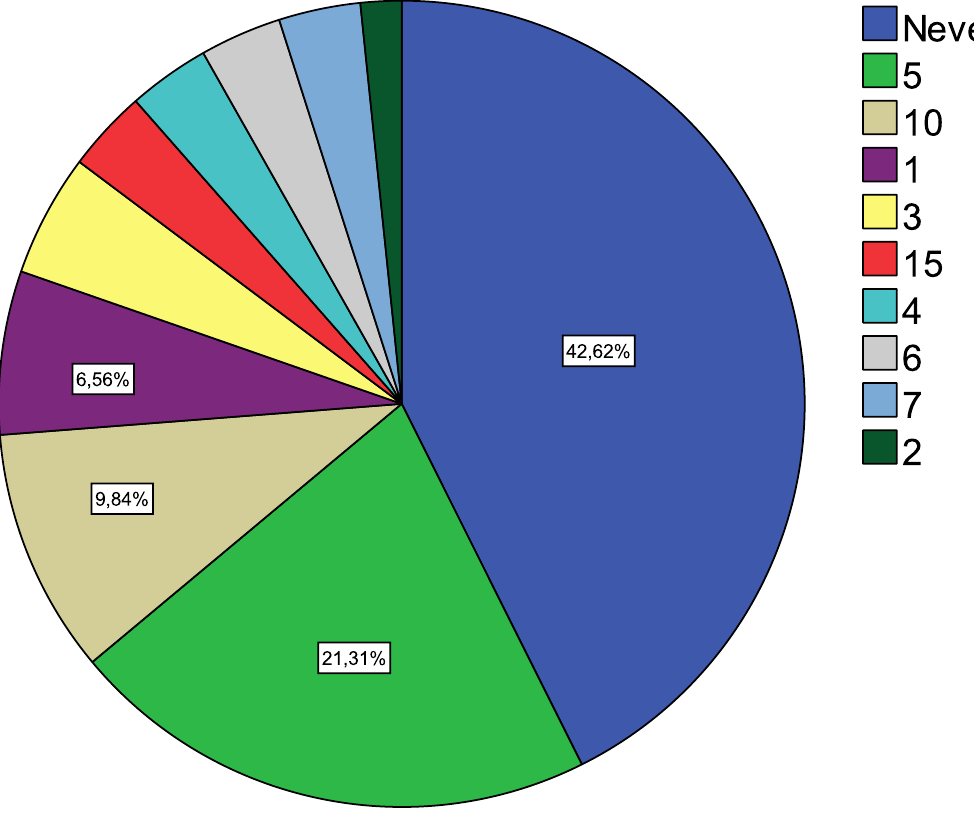
Figure 3. Years to implement.